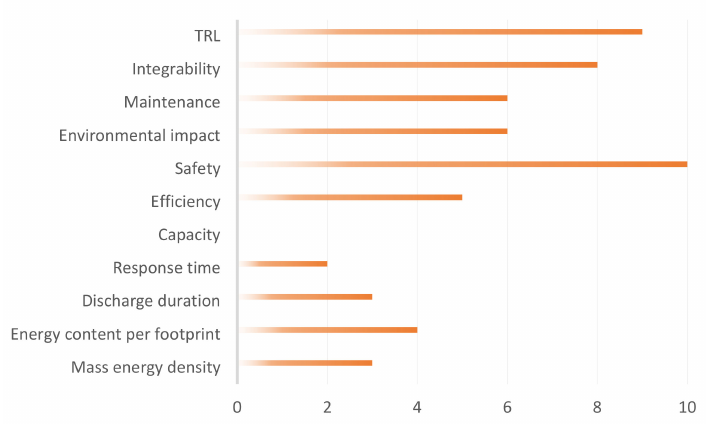
Figure 7. KPIs’ comparative ranking for Scenario